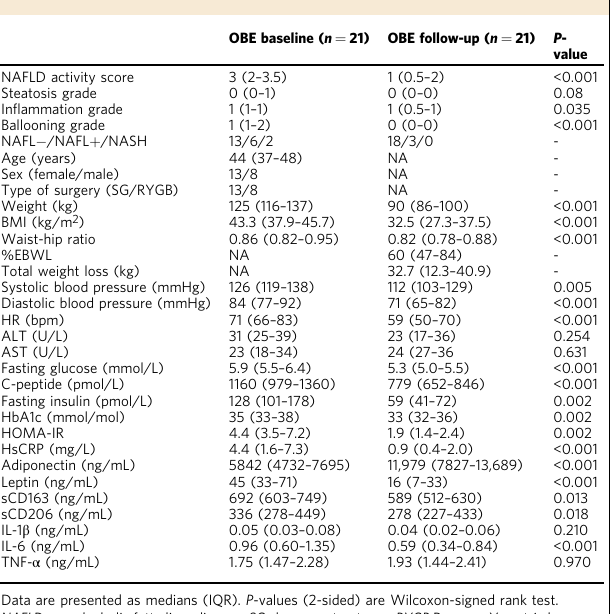
Table 3 Clinical and biochemical characteristics at baseline vs. follow-up 12 months after bariatric surgery in 21 OBE study